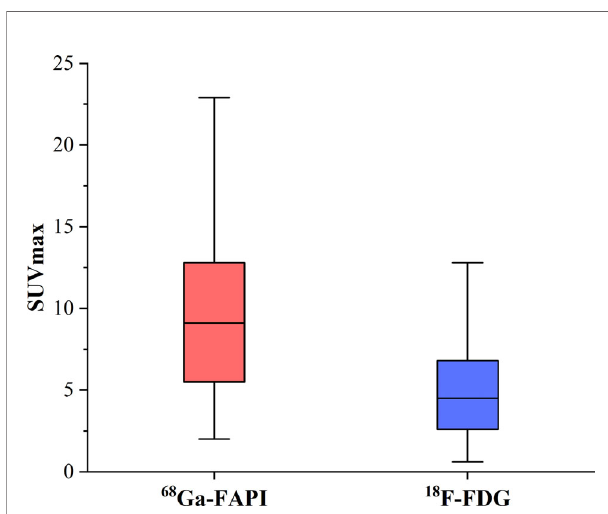
FIGURE 1 | The SUVmax of FAPI and FDG in 77 bone metastatic lesions. The tracer accumulation of [ 68 Ga]Ga-FAPI-04 in bone metastases is signi fi cantly higher than that of [ 18 F]FDG (n=109, median SUVmax, 9.1 vs 4.5; P< 0.01,